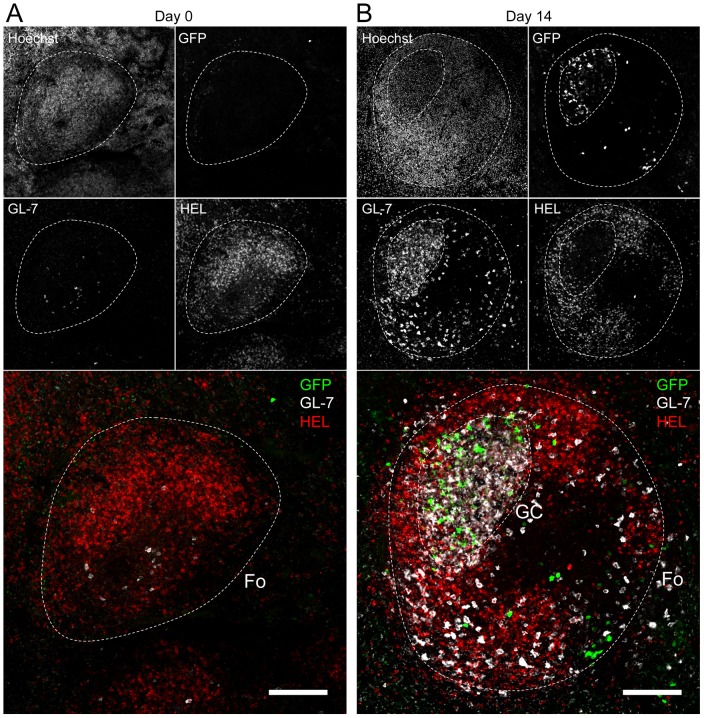
HEL+ B cells are excluded from the GC.Spleens were isolated from (A) day 0 (n = 2) and (B) day 14 (n = 4) infected SWHEL mice for microscopy analysis. Spleens were treated as indicated in the material and methods, and stained with an anti-GFP, anti-GL-7, HEL and nuclei dye Hoechst. Separate channels are shown as thumbnails, in the merge image below nuclei were excluded for clarity. Follicles (Fo) were localized based on Hoechst signal, showing delimited clusters of nuclei. GCs were identified as clusters of GL-7+ cells. Spleen sections were thoroughly analyzed and images shown are typical organization of splenic follicles of SWHEL mice at 0 and 14 dpi. At 14 dpi, infected cells were mainly localized within the GC, from which HEL+ B cells were systematically excluded. Scale bars represent 100 µm.